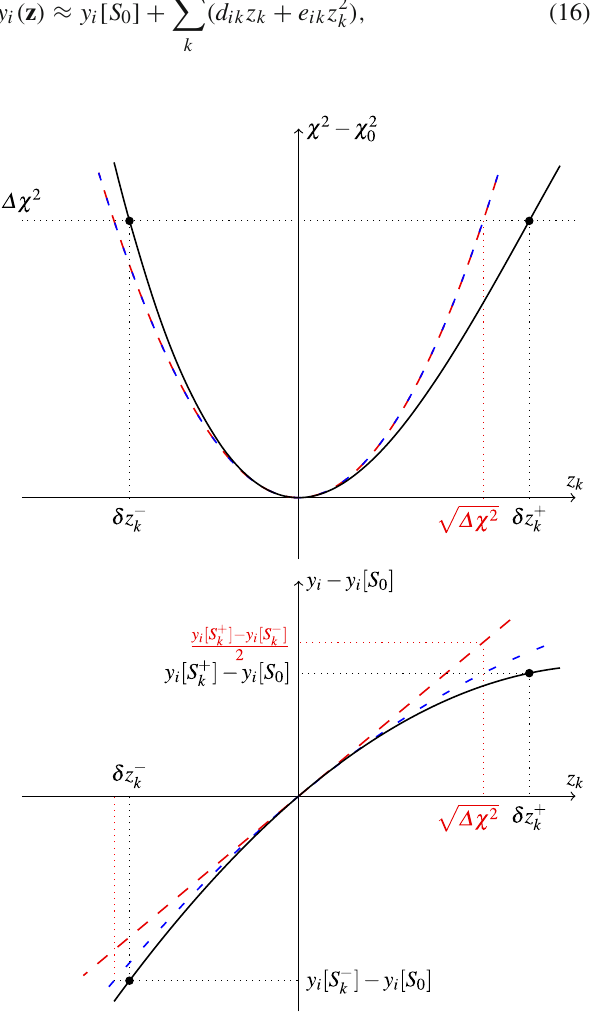
Fig. 1 An illustration for the response of χ 2 (top) and y i (bottom) with respect to a change of parameter z k in quadratic–linear (red, long dashed), quadratic–quadratic (blue, short dashed) and cubic–quadratic (black, solid)